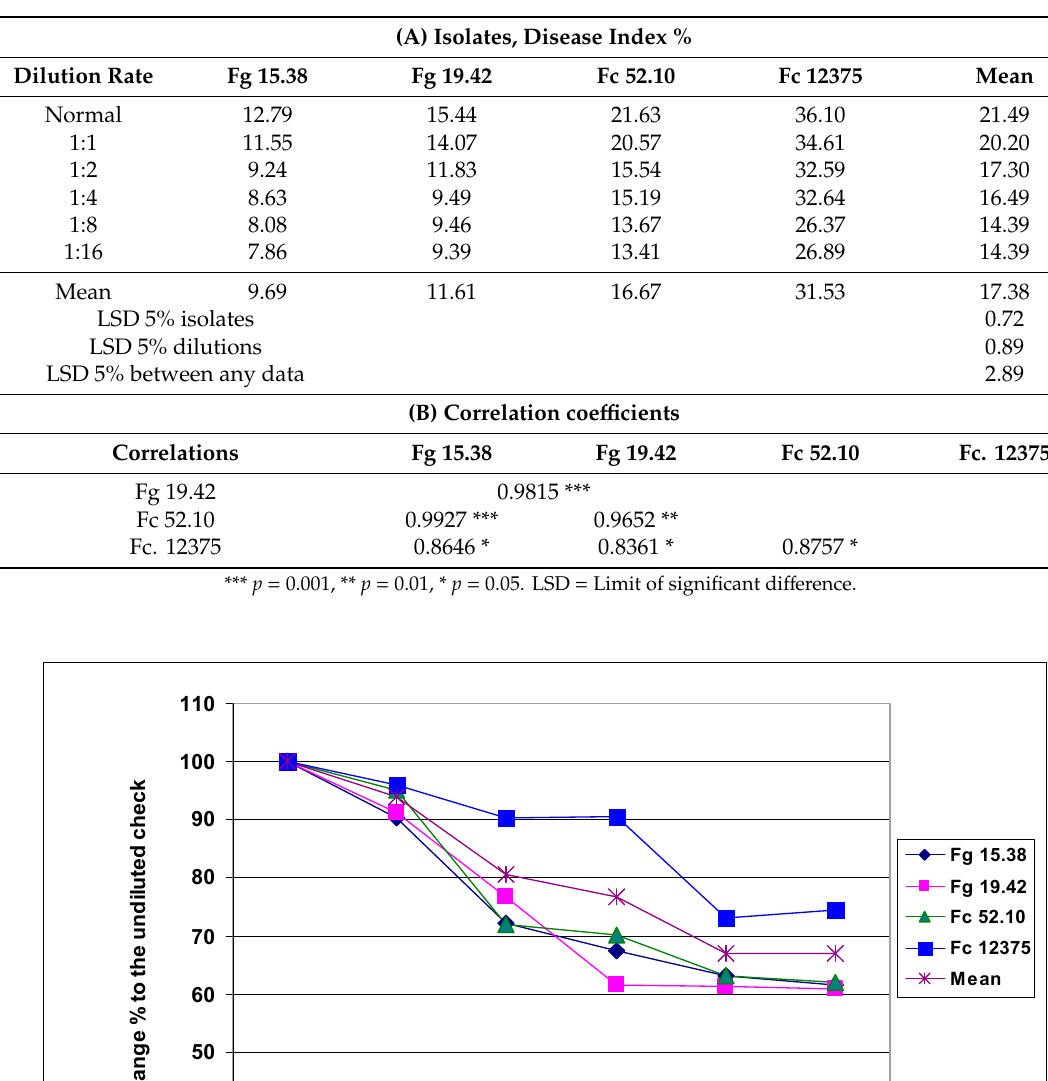
Table 2. Reduction of the aggressiveness of F. graminearum and F. culmorum isolates at di ff erent dilutions, visual screening data (Disease Index %) in 2013–2014. ( A ) Isolates, Disease Index %. ( B ) Correlation coe ffi cients.